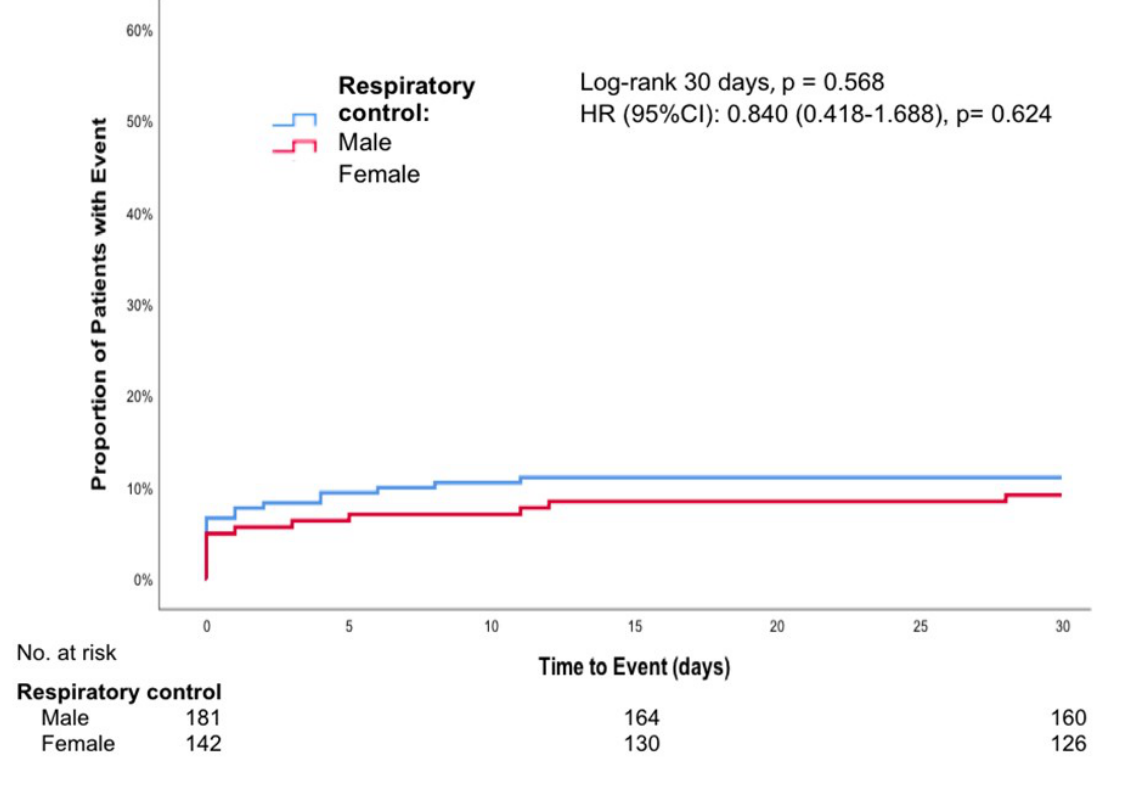
Figure S2: Composite Outcome of admission to ICU, rehospitalization for respiratory complication, death in 30 days in SARS-CoV-2 negative patients with respiratory infection (respiratory control